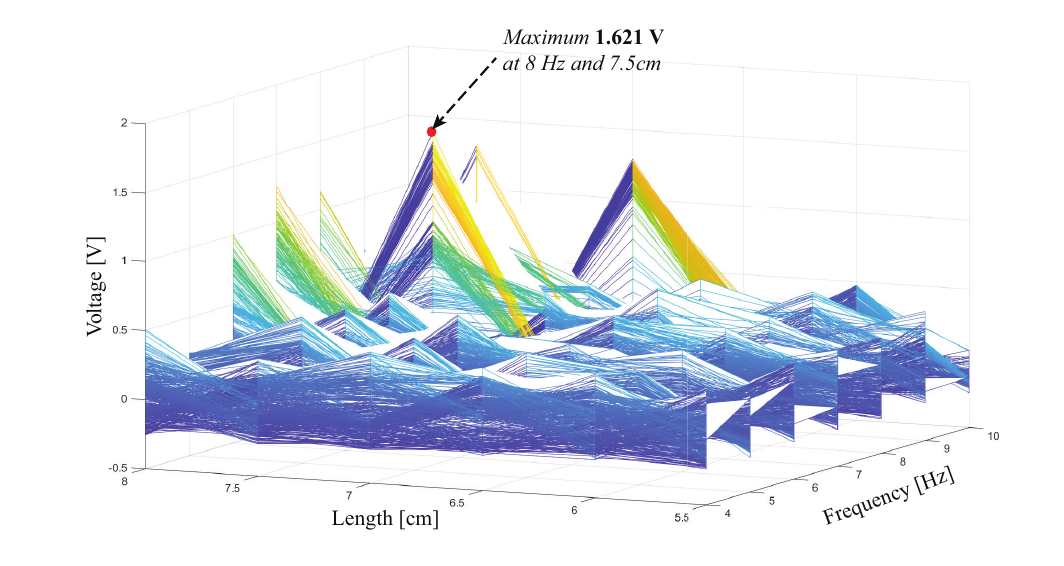
Figure 25. Energy harvesting for Replica 2. The maximum generated voltage was 1.621 V.